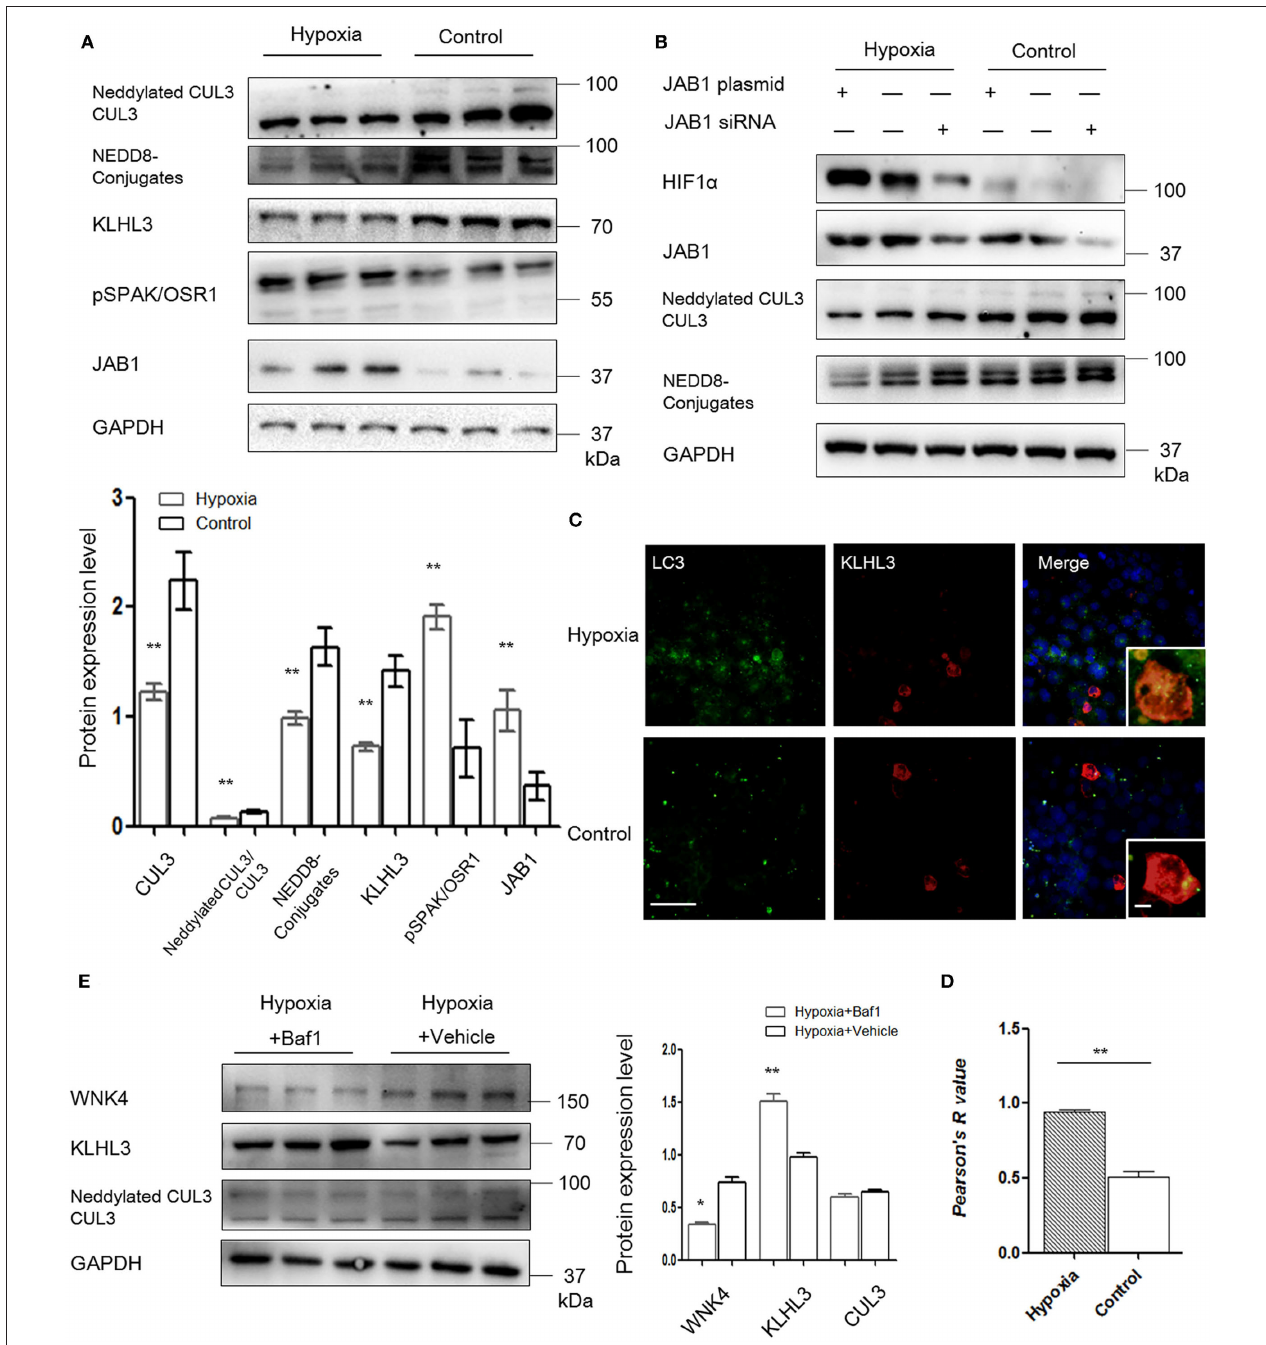
FIGURE 5 | JAB1 promoted HIF1 α expression and decreased neddylation of CUL3, and KLHL3 degradation was mediated by autophagy in HEK293 cells under hypoxia. (A) Protein levels of CUL3 abundance and neddylation, NEDD8 conjugates, adaptor KLHL3 and downstream phosphorylated SPAK/OSR1, and member of the COP9 signalosome JAB1 were detected in HEK293 cells after transfection with KLHL3. Expressions of these proteins in HEK293 cells were all statistically significant ( t -test) after normalization to GAPDH between hypoxia ( n = 3) and control ( n = 3) group. (B) Representative images of protein levels of hypoxia-inducible factor HIF1 α , JAB1, CUL3 abundance and neddylation in HEK293 cells after transfected with JAB1 and its siRNA, respectively ( n = 3). (C , D) Representative immunofluorescence images of subcellular localization of KLHL3 and autophagy marker LC3. The yellow fluorescence indicated the overlap of KLHL3 and LC3 expression. Scale bars: 100 µ m. Statistical analyses of KLHL3 and autophagy marker LC3 colocalization using Pearson correlation coefficient in HEK293 cells ( n = 10–15). (E) Representative immunoblots of WNK4, KLHL3, and CUL3 abundance and neddylation in HEK293 cells after administration with inhibitor of autophagy bafilomycin A1 (Baf1) under hypoxia. Data are presented as the mean ± SEM (* p < 0.05 and ** p < 0.01).